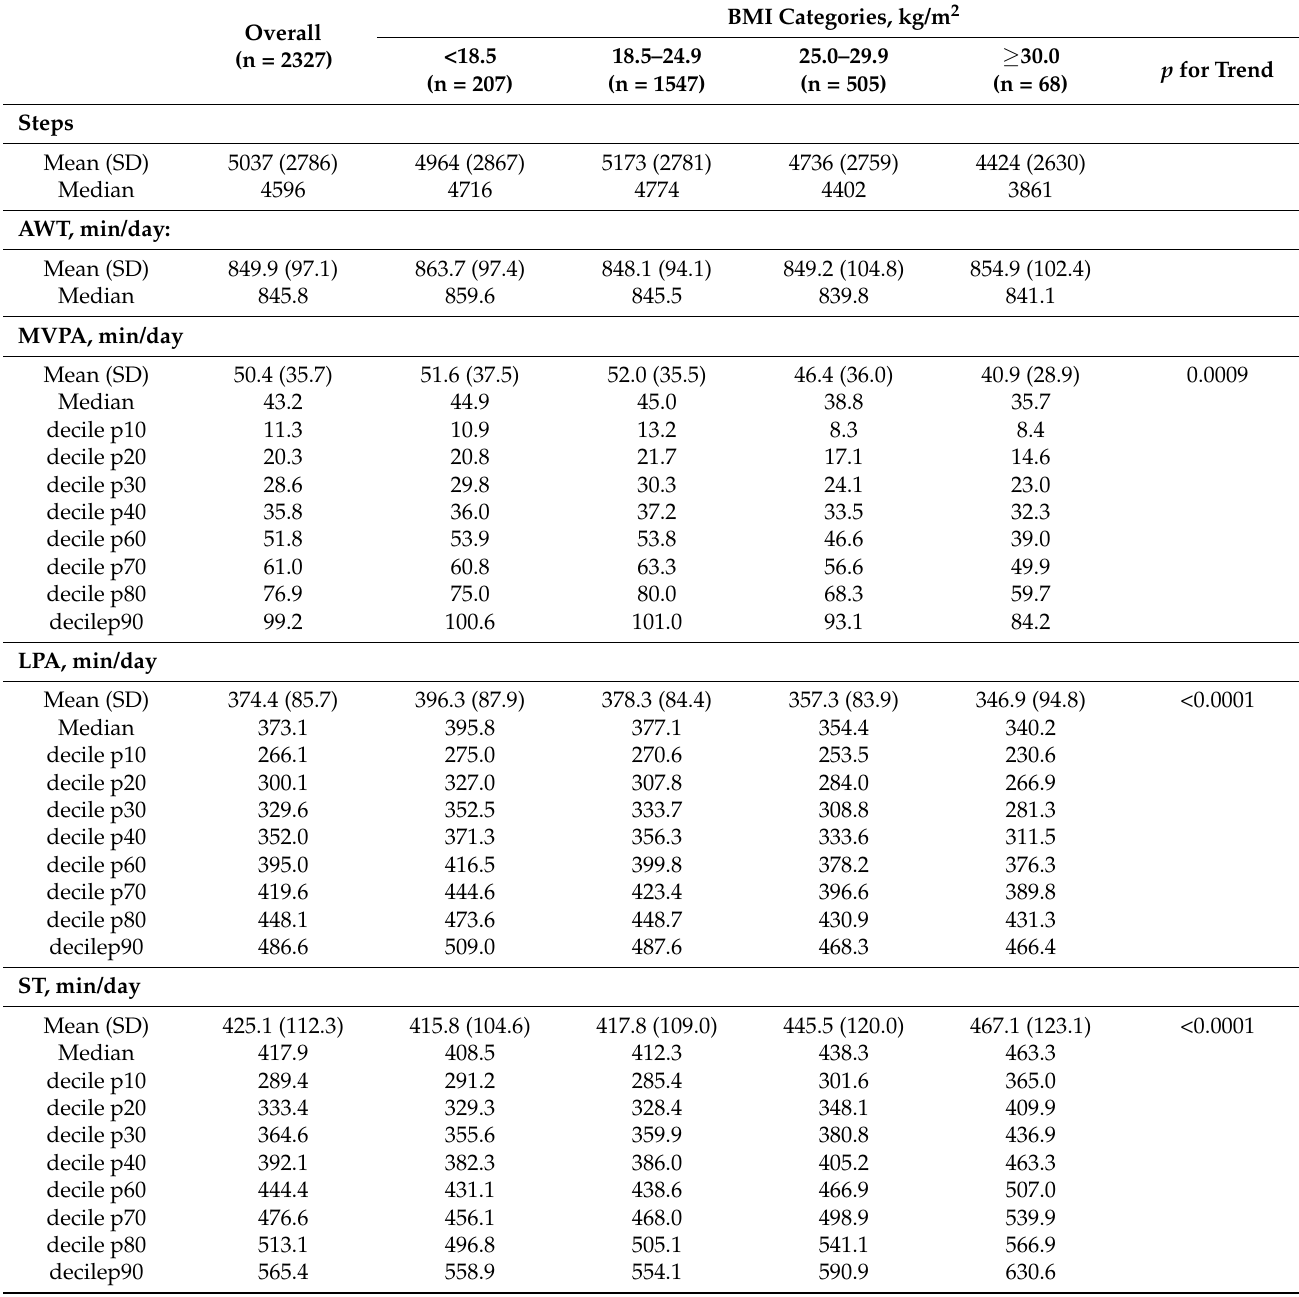
Table 4. Tri-axial accelerometer-determined PA and ST by BMI groups in the women (n =